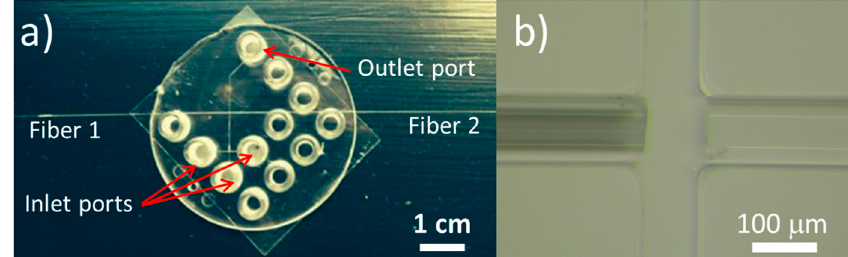
Figure 1. ( a ) Optofluidic chip in TOPAS 5013 L10 polymer with a system for hydrodynamic focusing of cells and embedded optical fibers. Optimal coupling with external fluidics is ensured by the presence of on-chip standard Luer connectors. The chip was designed with three inlet ports to allow hydrodynamic focusing of cells. ( b ) Detail of chip with a photonic crystal fiber (Left) and single-mode fiber (Right).